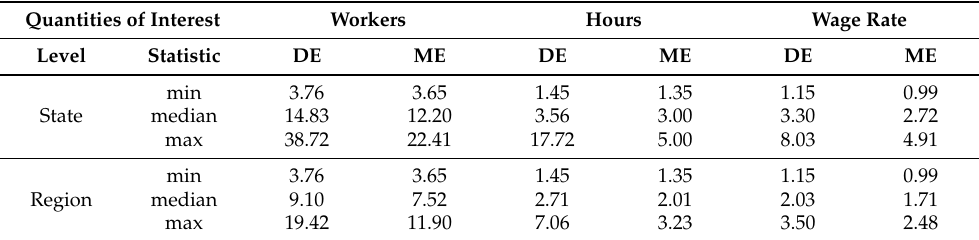
Table 1. Coefficients of variation (%) for all three estimates of hired workers at both state and regional